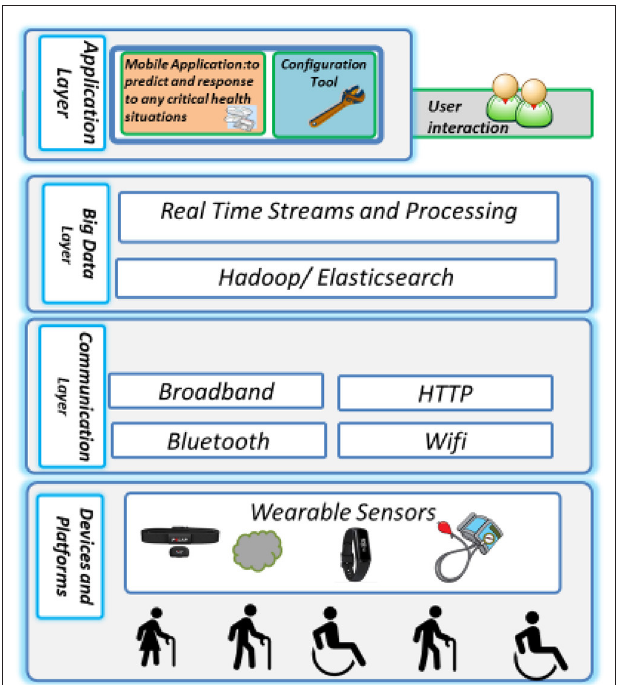
FIGURE 4 | The system